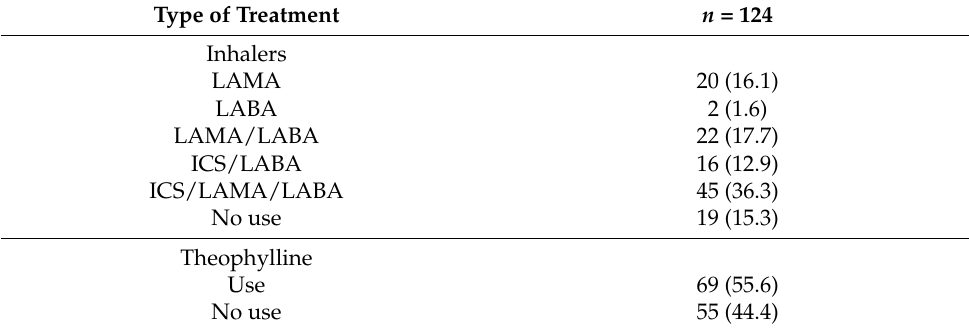
Table 3. Types of COPD treatment.